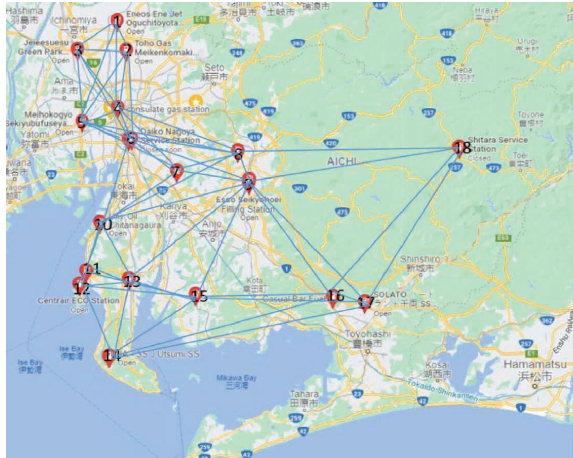
Figure 2: Te proposed graph of adjacency (Google